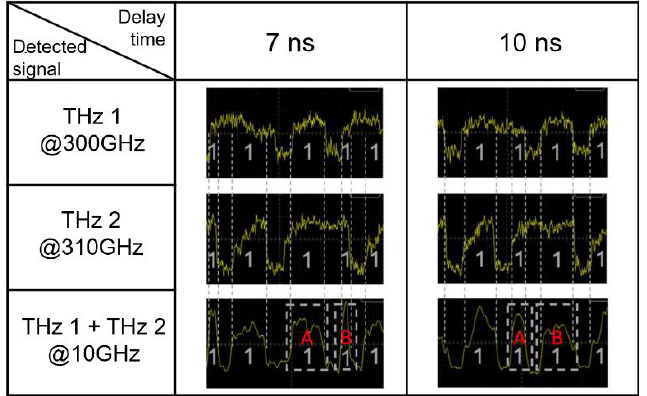
Figure 13. Observed waveforms of THz 1 ( upper ), THz 2 ( middle ) and THz 1 + THz2 ( lower